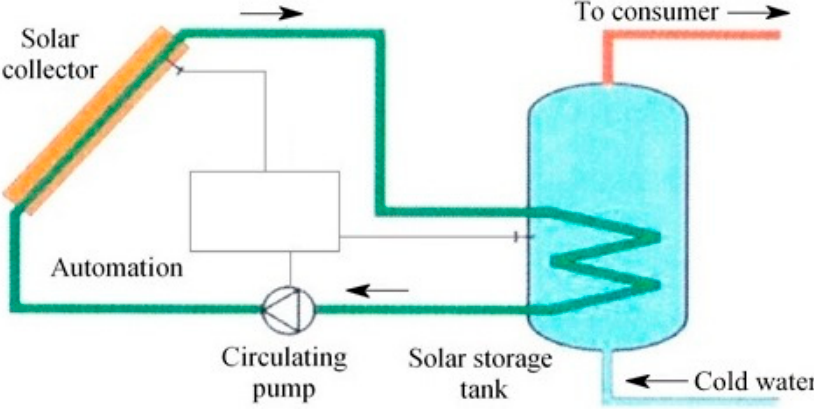
Figure 4. Conversion of solar energy to thermal energy.